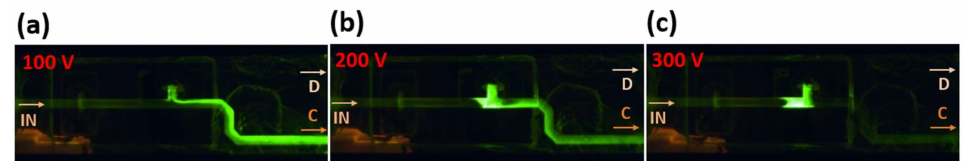
Figure 5. Visualization of desalination with the fluorescein solution for different values of inserted voltages at V D = 10 µ L/min, and V C = 5 /min. ( a ) continuous desalination, ( b ) unsuccessful operation, ( c ) desalination by